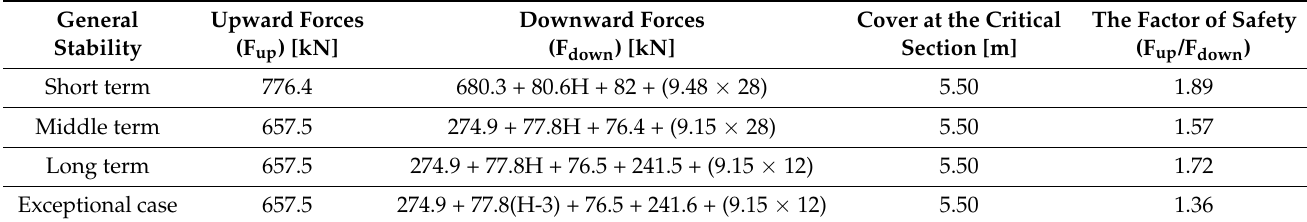
Table 2. The factor of safety calculation of tunnel-critical section.